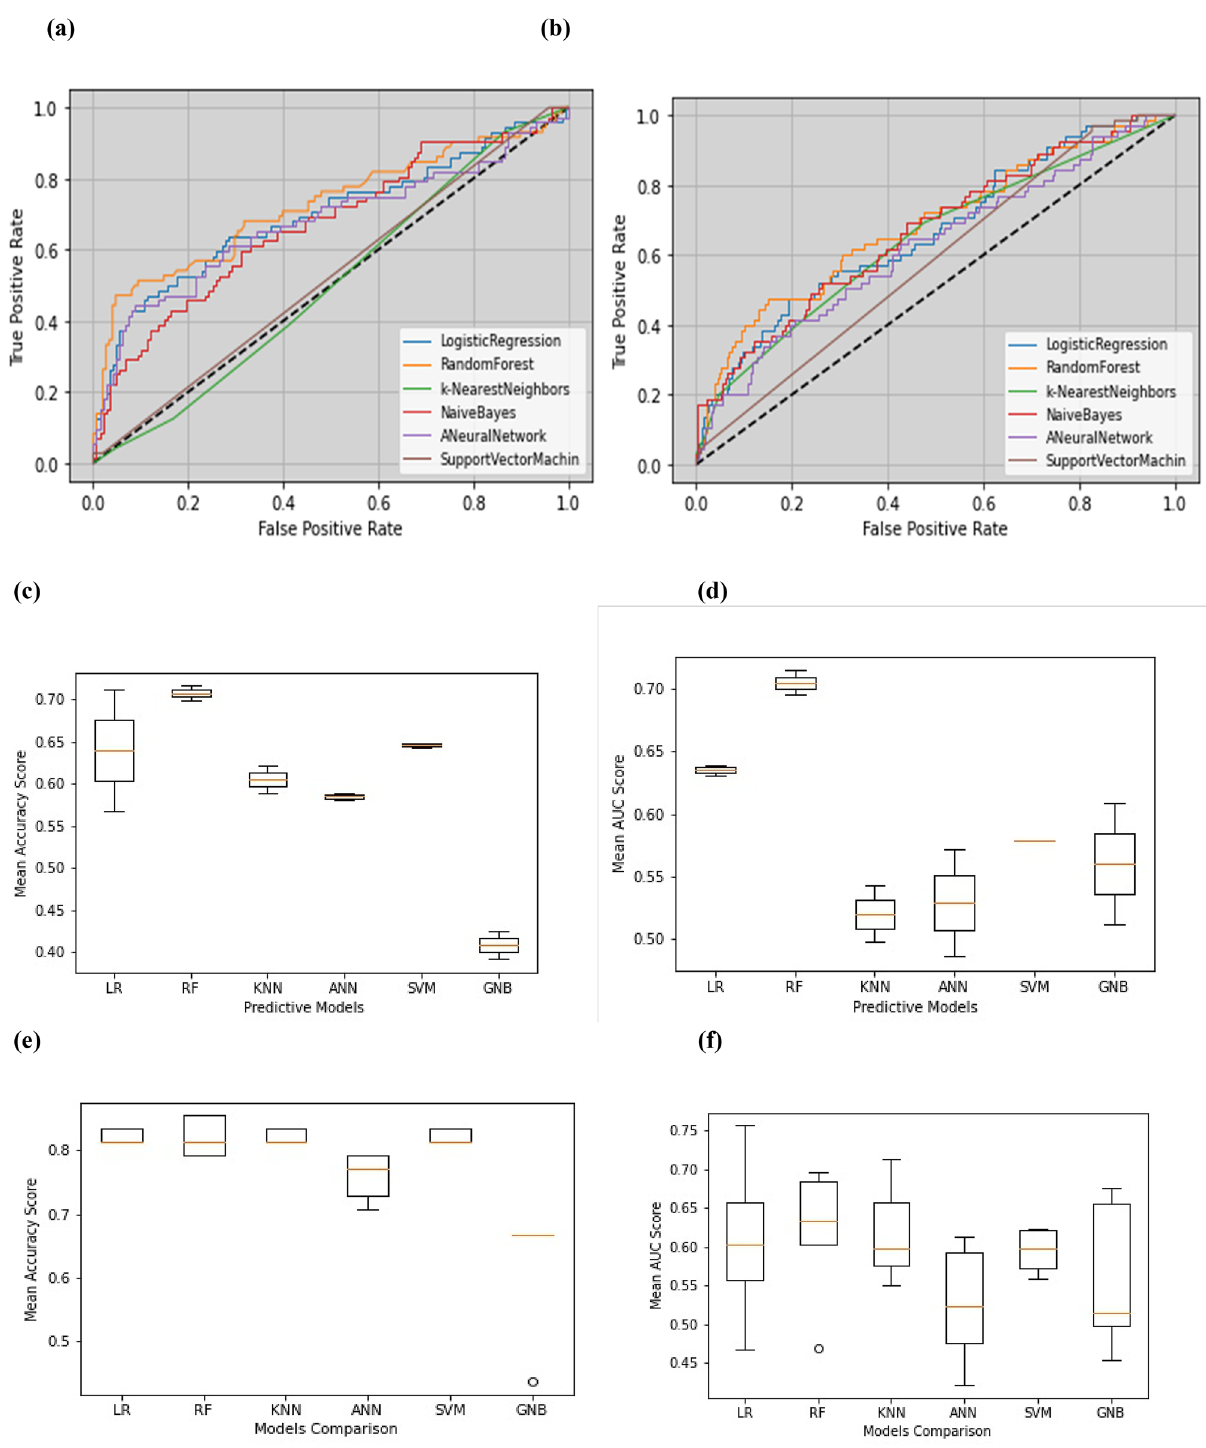
Figure 2. ROC Curves for IVF/ICSI and IUI. ( a ) ROC Curves by the models for IVF/ICSI; ( b ) ROC Curves by the models for IUI; Comparison among cross-validation process based on the accuracy ( c ) for IVF/ICSI ( e ) for IUI and AUC score ( d ) for IVF/ICSI and ( f ) for